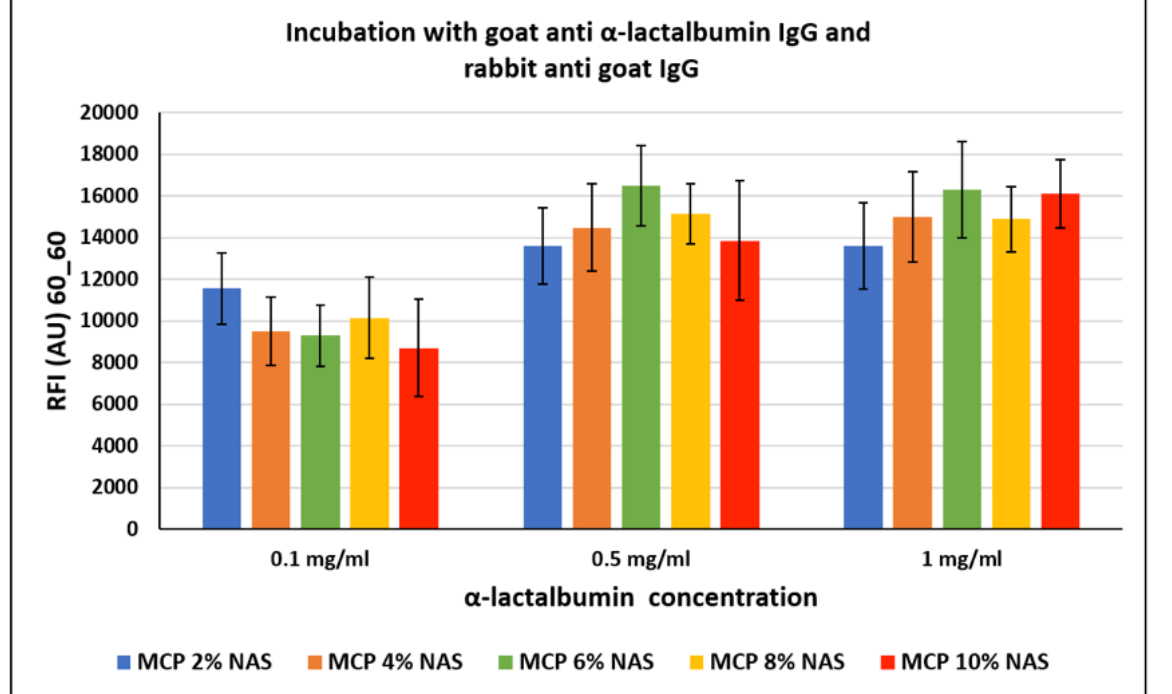
Figure 7. Fluorescence intensity signals obtained on silicon slides coated with MCP NAS polymers, spotted with increasing concentrations of α -lactalbumin and incubated with a goat α -lactalbumin IgG and then with a Cy3-labelled rabbit anti-goat IgG for fluorescence detection. Fluorescence was measured with a confocal laser scanner with power set at 60% and the photomultiplier tube gain (PMT) at 60%. The reported signal intensities are the average of the Relative Fluorescence Intensity (RFI) of each 10 × 2 subarray, each corresponding to a single protein concentration. Therefore, the error bars are the standard deviations of the fluorescence intensity of 20 spots.